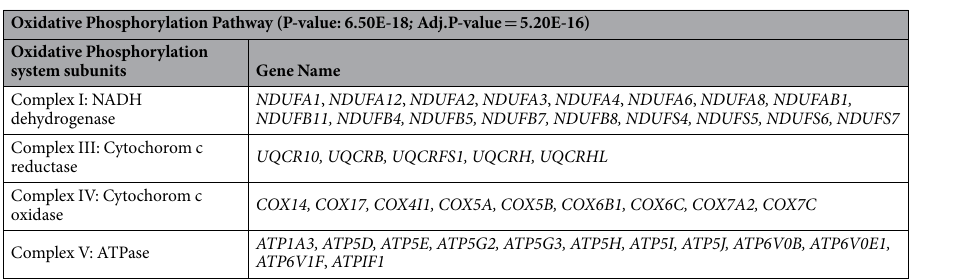
Table 2. The upregulated genes involved in Oxidative Phosphorylation pathway in primary monocytes of the XLA patients compared to healthy